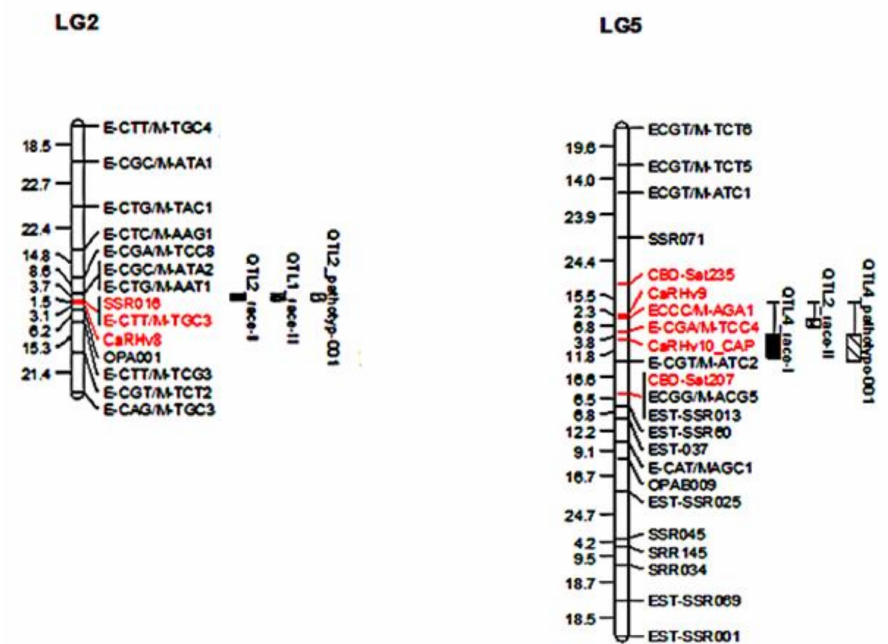
Figure 2. LG2 = Linkage Group 2 of the C. arabica genetic map, containing the marker CaRHv8 (red) and its originated AFLP marker E-CTT \ M-TGC3 (red). LG5 = Linkage Group 5 of the C. arabica genetic map, containing the markers CaRHv9, CaRHv10_CAPS, and their originated AFLP markers CBD-Sat207 and CBD-Sat235 (red). The names of the molecular markers are indicated to the right of the bar, and the distances in cM are shown to the left of the